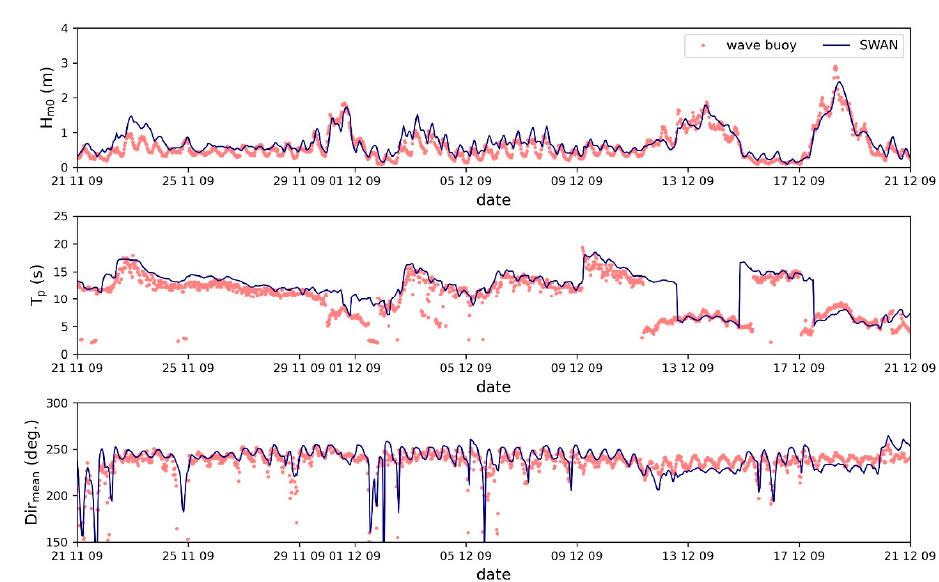
Figure 6. Time series of measured and computed significant wave height H m0 , peak period T p and mean wave direction Dir mean (anticlockwise convention from east) at wave buoy 02910.